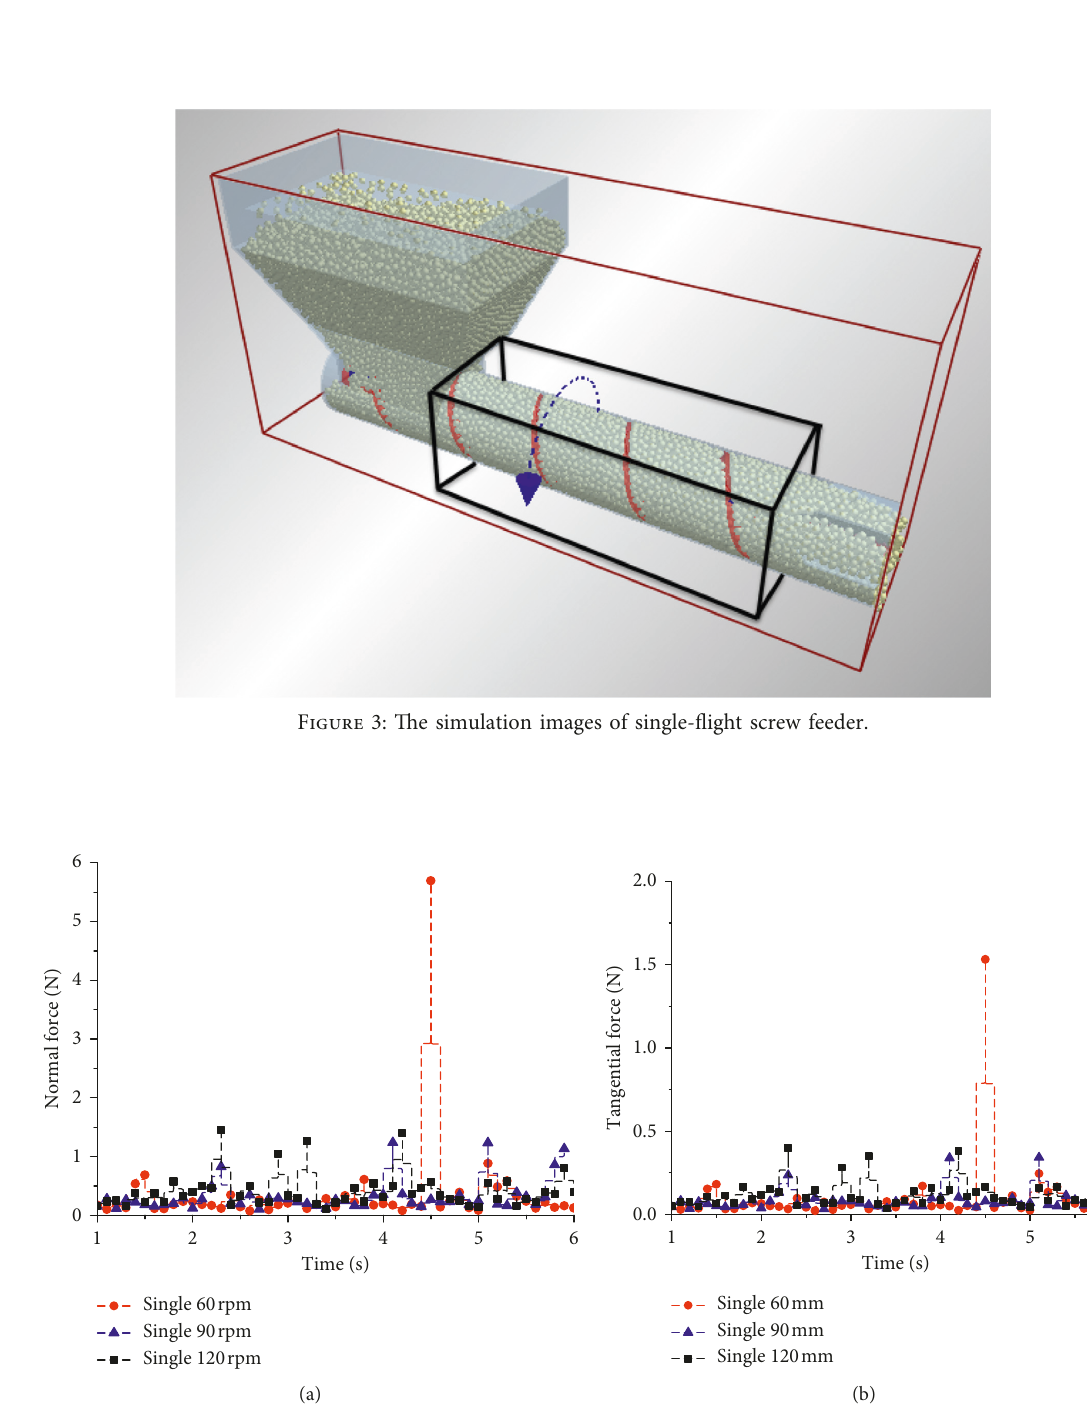
Figure 4: The contact force between particles at three different speeds in the single-flight screw